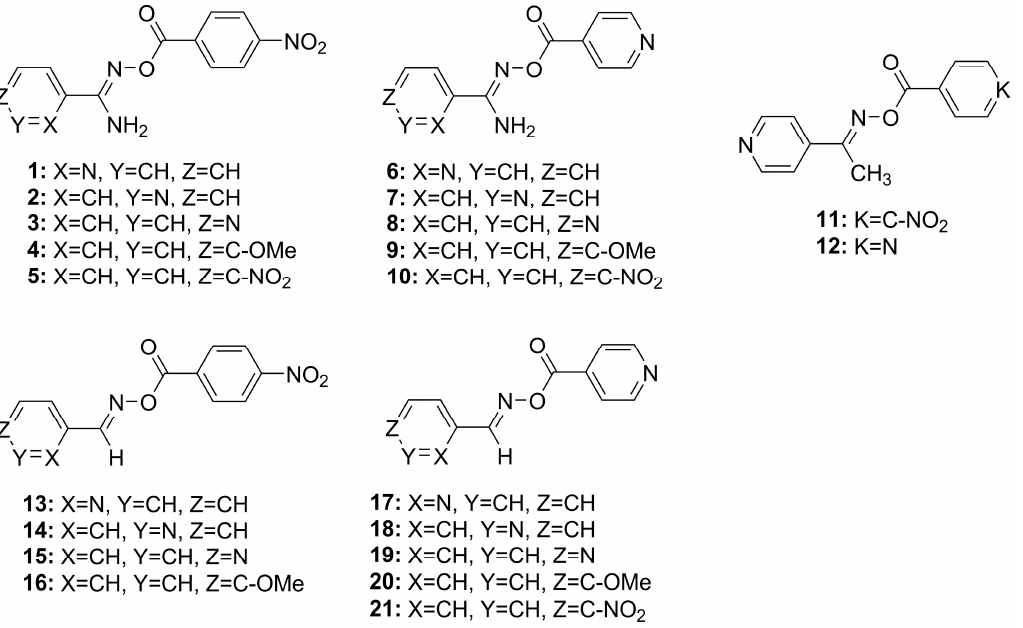
Figure 2. Structures of the amidoxime p -nitrobenzoyl conjugates ( 1 – 5 ), amidoxime pyridoyl conjugates ( 6 – 10 ), ethanone oxime p -nitrobenzoyl conjugate ( 11 ) and pyridoyl conjugates ( 12 ), aldoxime p -nitrobenzoyl conjugates ( 13 – 16 ) and aldoxime pyridoyl conjugates ( 17 – 21 ).